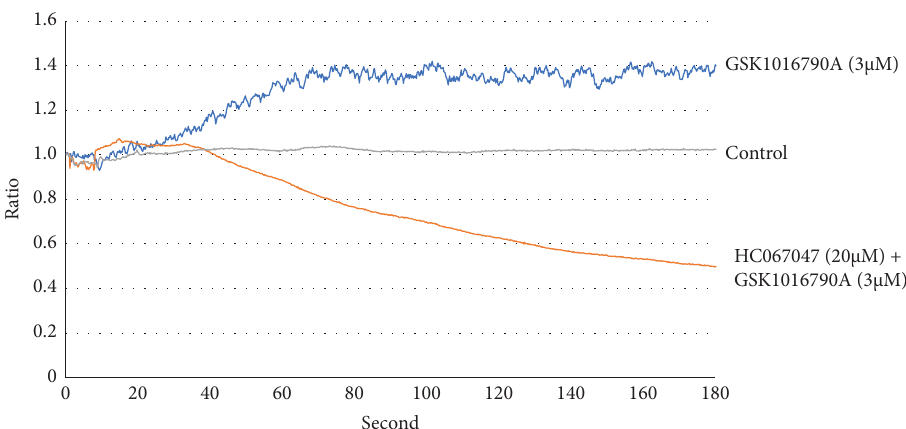
Figure 4: TRPV4-mediated changes in cytosolic Ca 2+ in MGN3-1 cells. Te efects of GSK1016790A and HC 067047 on [Ca 2+ ] cells. Compared to the control level at 180s, [Ca2+] i increased in MGN3-1 cells treated with GSK1016790A ( n � 20, p < 0 . 01) but decreased in cells treated with GSK1016790A and HC067047 ( n � 20, p < 0 . 01) (GSK1016790A, TRPV4 agonist; HC067047, TRPV4